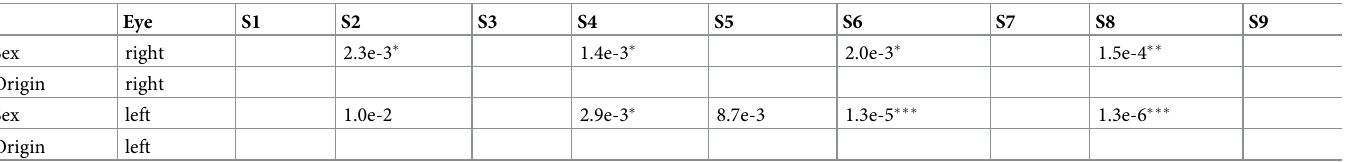
Table 7. Summary of p-values in two-way analysis of variance (ANOVA) for measured choroidal thickness parameters in right (first two rows) and left (last two rows) eyes in relation to sex and origin. Eye S1